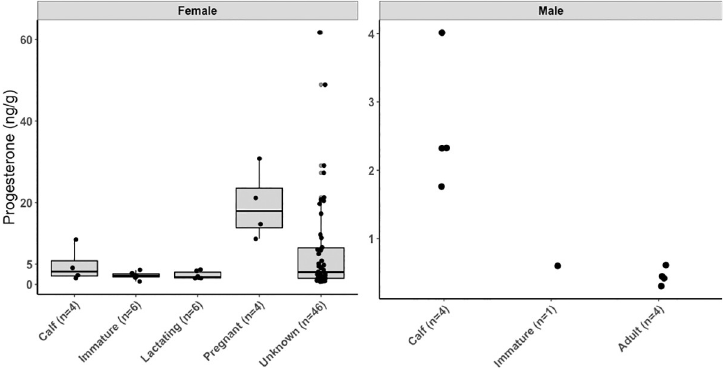
Fig 5. Progesterone concentrations in female and male gray whales. Differences in concentrations were statistically different among reproductive groups for female and male gray whales (ANOVA: F = 31.09, df = 6.00, P < 0.001) of known reproductive status. Boxplots denote median (thick line), upper (75%) and lower (25) quartile (boxes) and largest and smallest value within 1.5 times interquartile range below 25% and above 75% (whiskers).